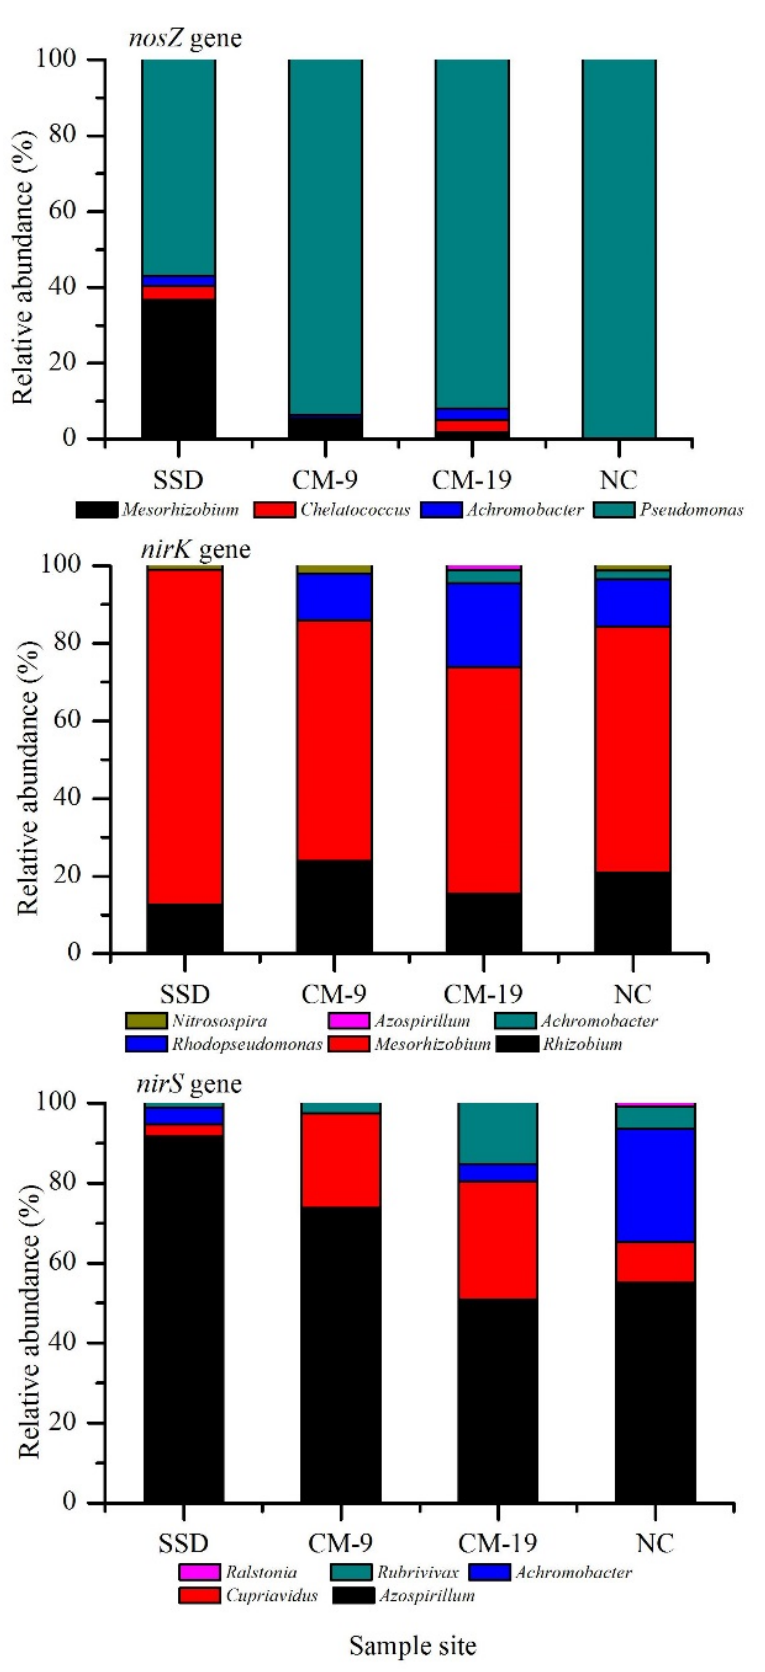
Figure 5. Relative abundance of different denitrifying genes. SSD: shifting sand dune; CM-9: 9-yr C. microphylla forest; CM-19: 19-yr C. microphylla forest; NC: natural C. microphylla forest.